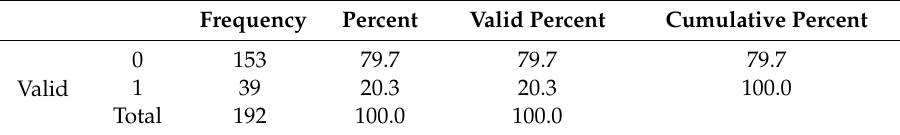
Table 20. Frequency table sharing of cars will get me tax relief from the government.